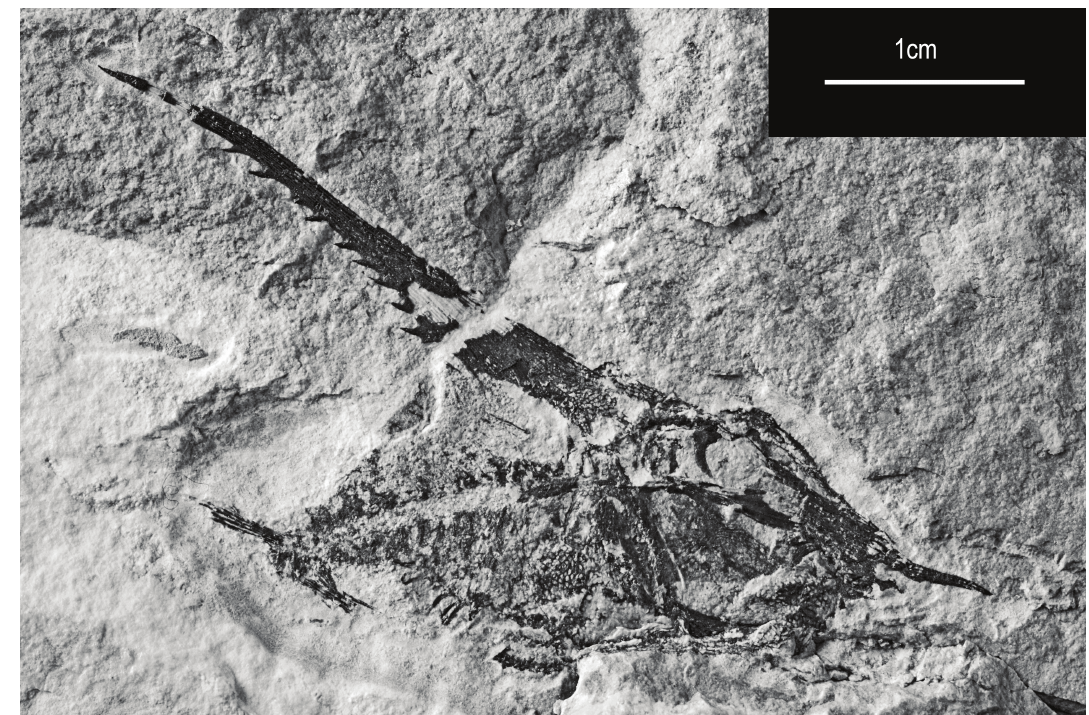
Fig. 17. Pankowskichthys libanicus gen. et sp. nov. Holotype, IRSNB P 9278.